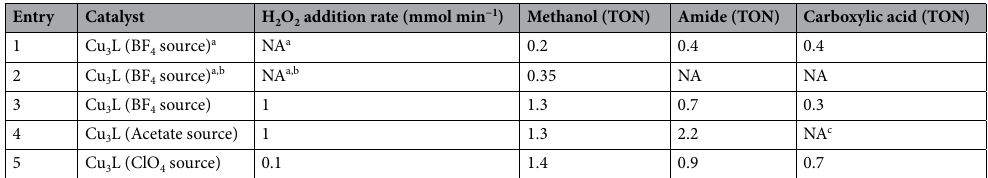
Table 2. Complex activity towards methanol production regenerated by hydrogen peroxide addition rate. Reaction conditions: Copper complex 0.04 mmol(1.3% of total H 2 O 2 ), acetonitrile 18 eq (57.5